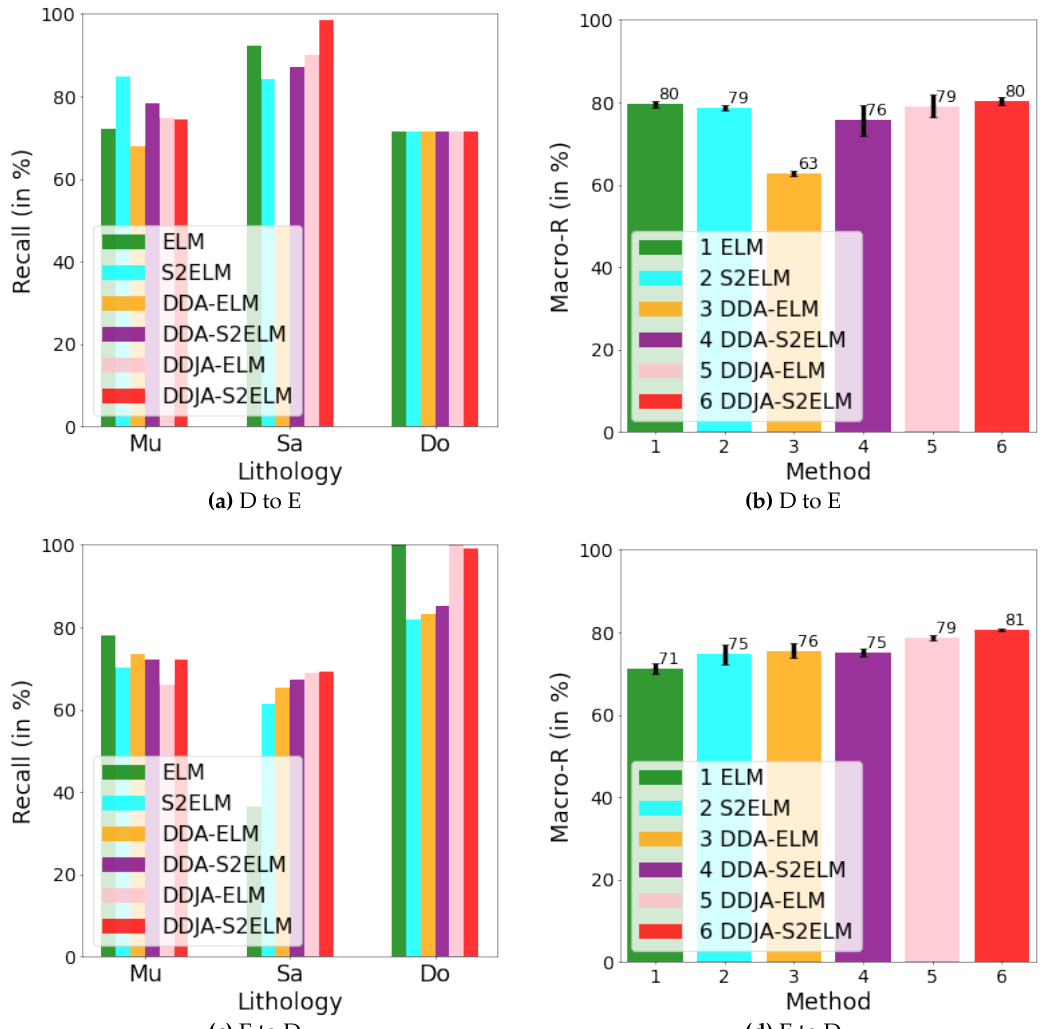
Figure 5. The results of performing our method on dataset 2. In ( a ) and ( b ), we show the recalls for the classes of Mu, Sa, and Do and their macro average recall by transferring D to E. In ( c ) and ( d ), we show those by transferring E to